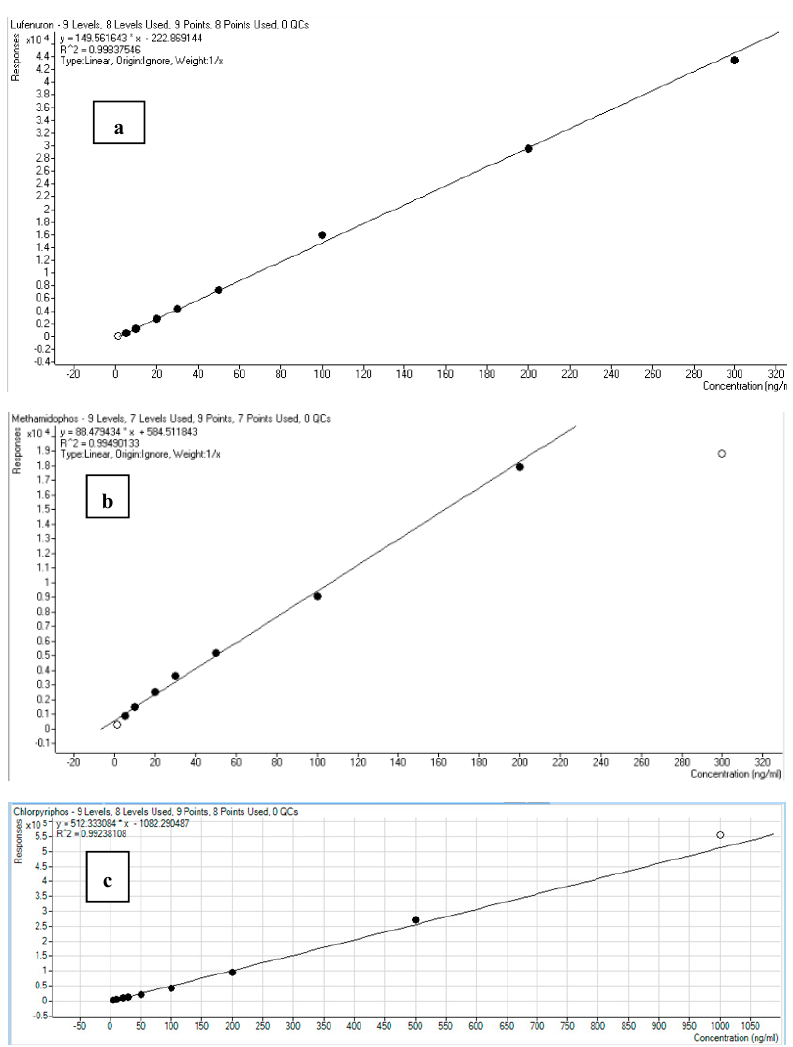
Figure 2. LC standard calibration curves for ( a ) lufeneron, ( b ) methamidophos and ( c ) chlorpyriphos at 5, 10, 20, 30, 50, 100, 200, 500 µg/L.